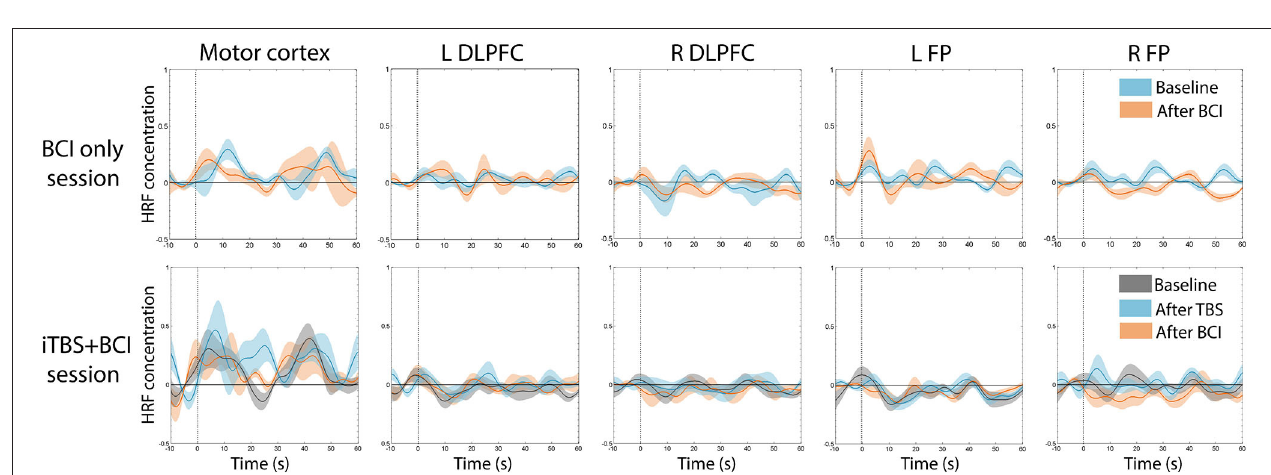
FIGURE 6 | Average time series of HRF across participants. There was no significant change in average HbO2 amplitude at any time point in either session. In BCI-only session (top panel), blue indicates HRF at baseline, and pink indicates HRF after BCI training. In iTBS + BCI session (bottom panel), gray indicates HRF at baseline; blue indicates HRF after TBS; and pink indicates HRF after BCI training. Error bars are standard